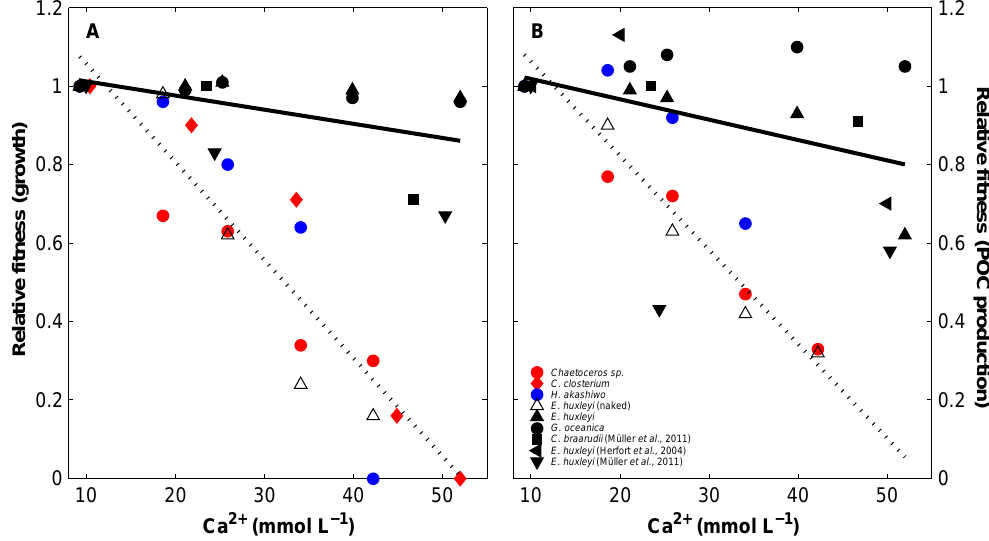
Figure 3. Relative physiological response of phytoplankton species to seawater Ca 2 + concentration. Relative fitness expressed in terms of (a) growth rate and (b) POC production of all tested species normalized to ambient seawater Ca 2 + concentration of ∼ 10mmolL − 1 , and supplemented with coccolithophore literature data from Müller et al. (2011) and Herfort et al. (2004) to illustrate the effect of cal- cium poisoning on calcifiers and non-calcifiers. Solid lines indicate regressions through calcifiers: (a) y = − 0 . 0036 ×+ 1 . 0483 ( r 2 = 0.278, p = 0.035, n = 16) and (b) y = − 0 . 0052 ×+ 1 . 0704 ( r 2 = 0.184, p = 0.067, n = 19). Dotted lines indicate regressions through non-calcifiers: (a) y = − 0 . 025 ×+ 1 . 307 ( r 2 = 0.858, p <0.0001, n = 20) and (b) y = − 0 . 024 ×+ 1 . 303 ( r 2 = 0.826, p <0.0001, n =